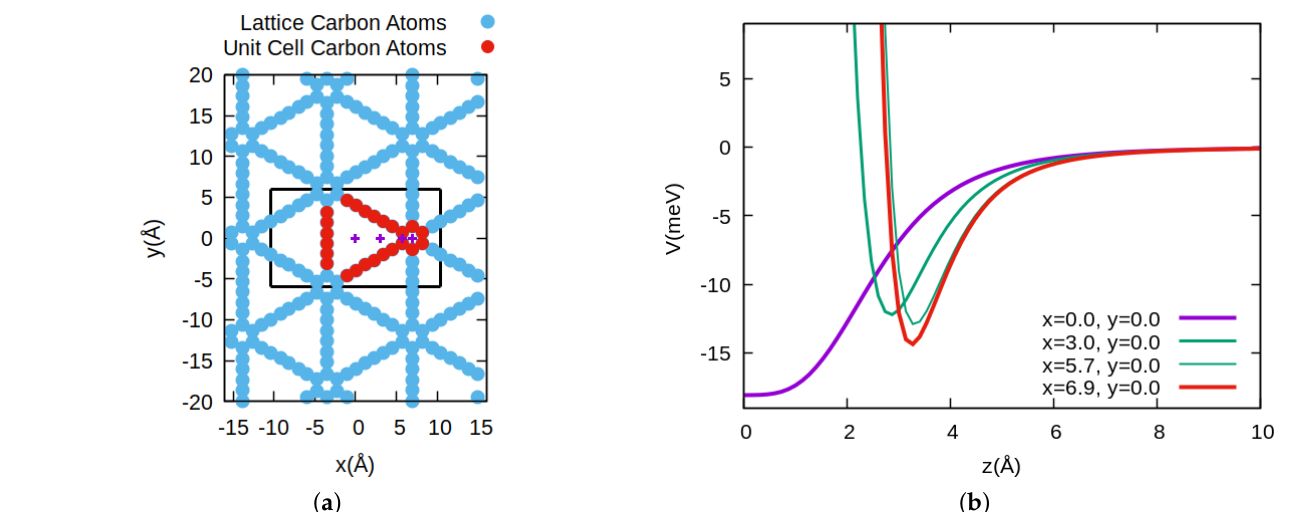
Figure 1. ( a ) Graphtriyne lattice. The red filled points represent the atoms of the unit cell and the rectangle indicates the ( x , y ) grid for the wave packet propagation. Crossed points indicate z directions at which the interaction potential is computed, as shown in in the right panel. ( b ) Interaction potential along the z coordinate at several ( x , y ) positions indicated in the lower right part, and by crossed points in the left